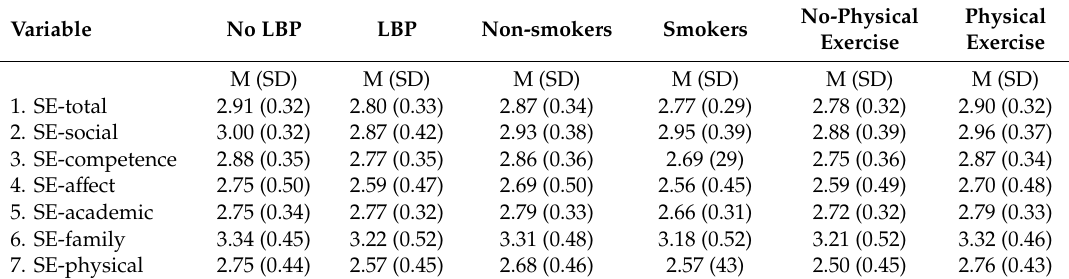
Table 3. Descriptive statistics for total SE scores and SE subscales by lower back pain (LBP) su ff erers